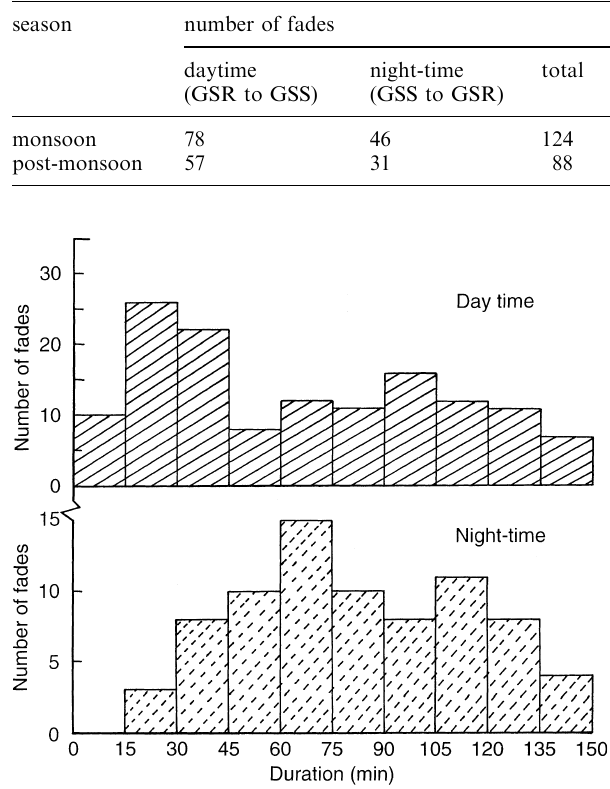
Fig. 3. Duration of fades during daytime and night-time